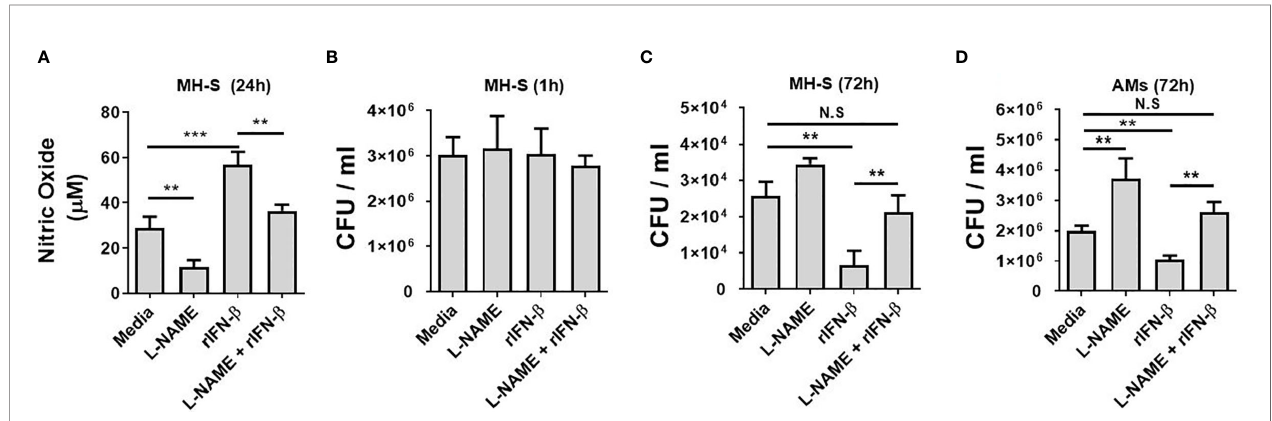
FIGURE 3 | Type I IFNs inhibits the intracellular MAB growth in macrophages by regulating NO production. (A – C) MH-S cells were incubated with MAB and indicated reagents (2 h pretreated). (A) Nitric oxide concentration in cell culture supernatant was measured by Griess reaction at 24 h post infection. Intracellular bacterial CFU on (B) 1 h and (C) 72 h were evaluated by intracellular bacterial growth assay. (D) AMs were incubated with MAB (MOI 1:25) and indicated reagents (2 h pretreated, L -NAME 1 mM, rIFN- b 1,000 units/ml). Intracellular bacterial CFU on 72 h was evaluated by intracellular bacterial growth assay. (A – D) The results are from one representative experiment of two independent experiments (**p < 0.01, ***p < 0.001). MAB, Mycobacterium abscessus ; IFN, interferon; CFU, colony- forming unit; AMs, alveolar macrophages; MOI, multiplicity of infection. NS, Not Statistically Signi fi